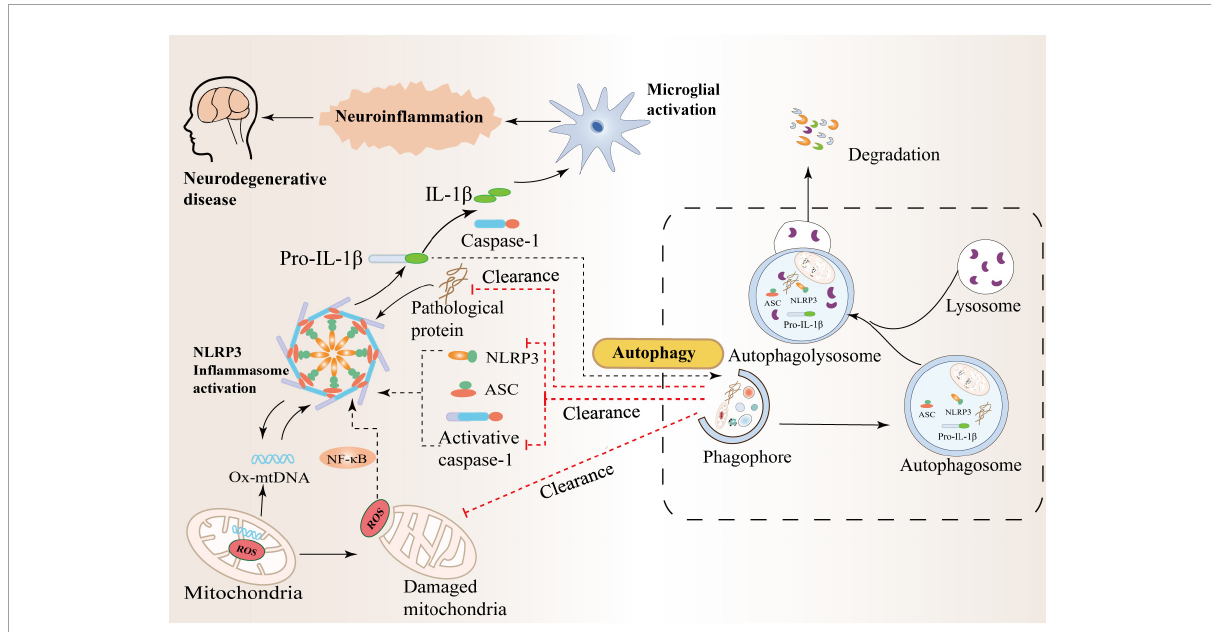
FIGURE3 Crosstalk between autophagy and the NLRP3 inflammasome in neurodegenerative diseases. Autophagy can inhibit NLRP3 inflammasome activation by scavenging reactive oxygen species (ROS). The production of massive ROS by damaged mitochondria can activate the NF- κ B pathway and promote the transcription of NLRP3 and pro-IL-1 β , thereby activating the NLRP3 inflammasome. In addition, autophagy can also inhibit the activation of NLRP3 by increasing the phosphorylation of NLRP3 and degrading inflammatory components such as activated Caspase-1, IL-1 β , and ASC. Therefore, there is an interaction between inflammation and autophagy to prevent excessive inflammatory responses in the